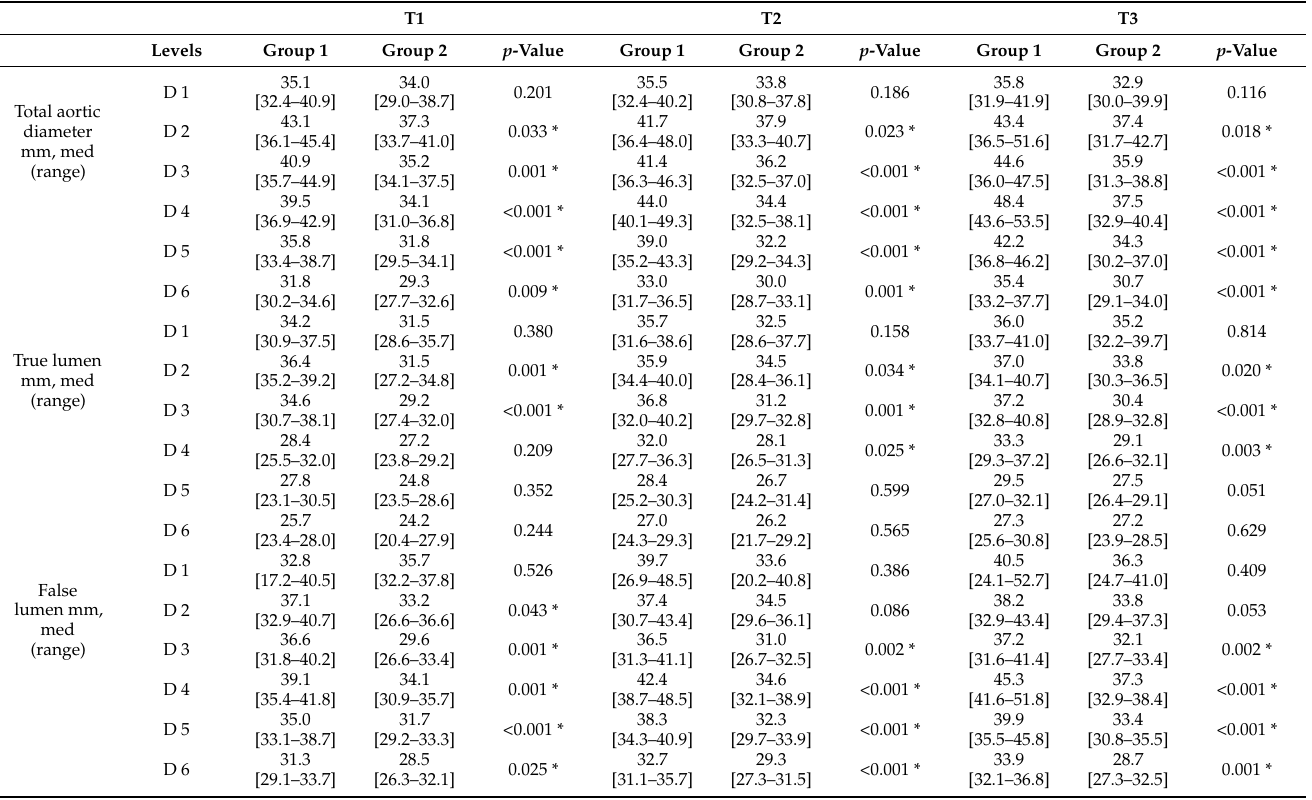
Table 2. Comparison of the measurement of the diameter at each level of the thoracic aorta between groups 1 and 2 at T1 (postoperative CT scan), T2 (3 months) and T3 (1 year). T1 T2